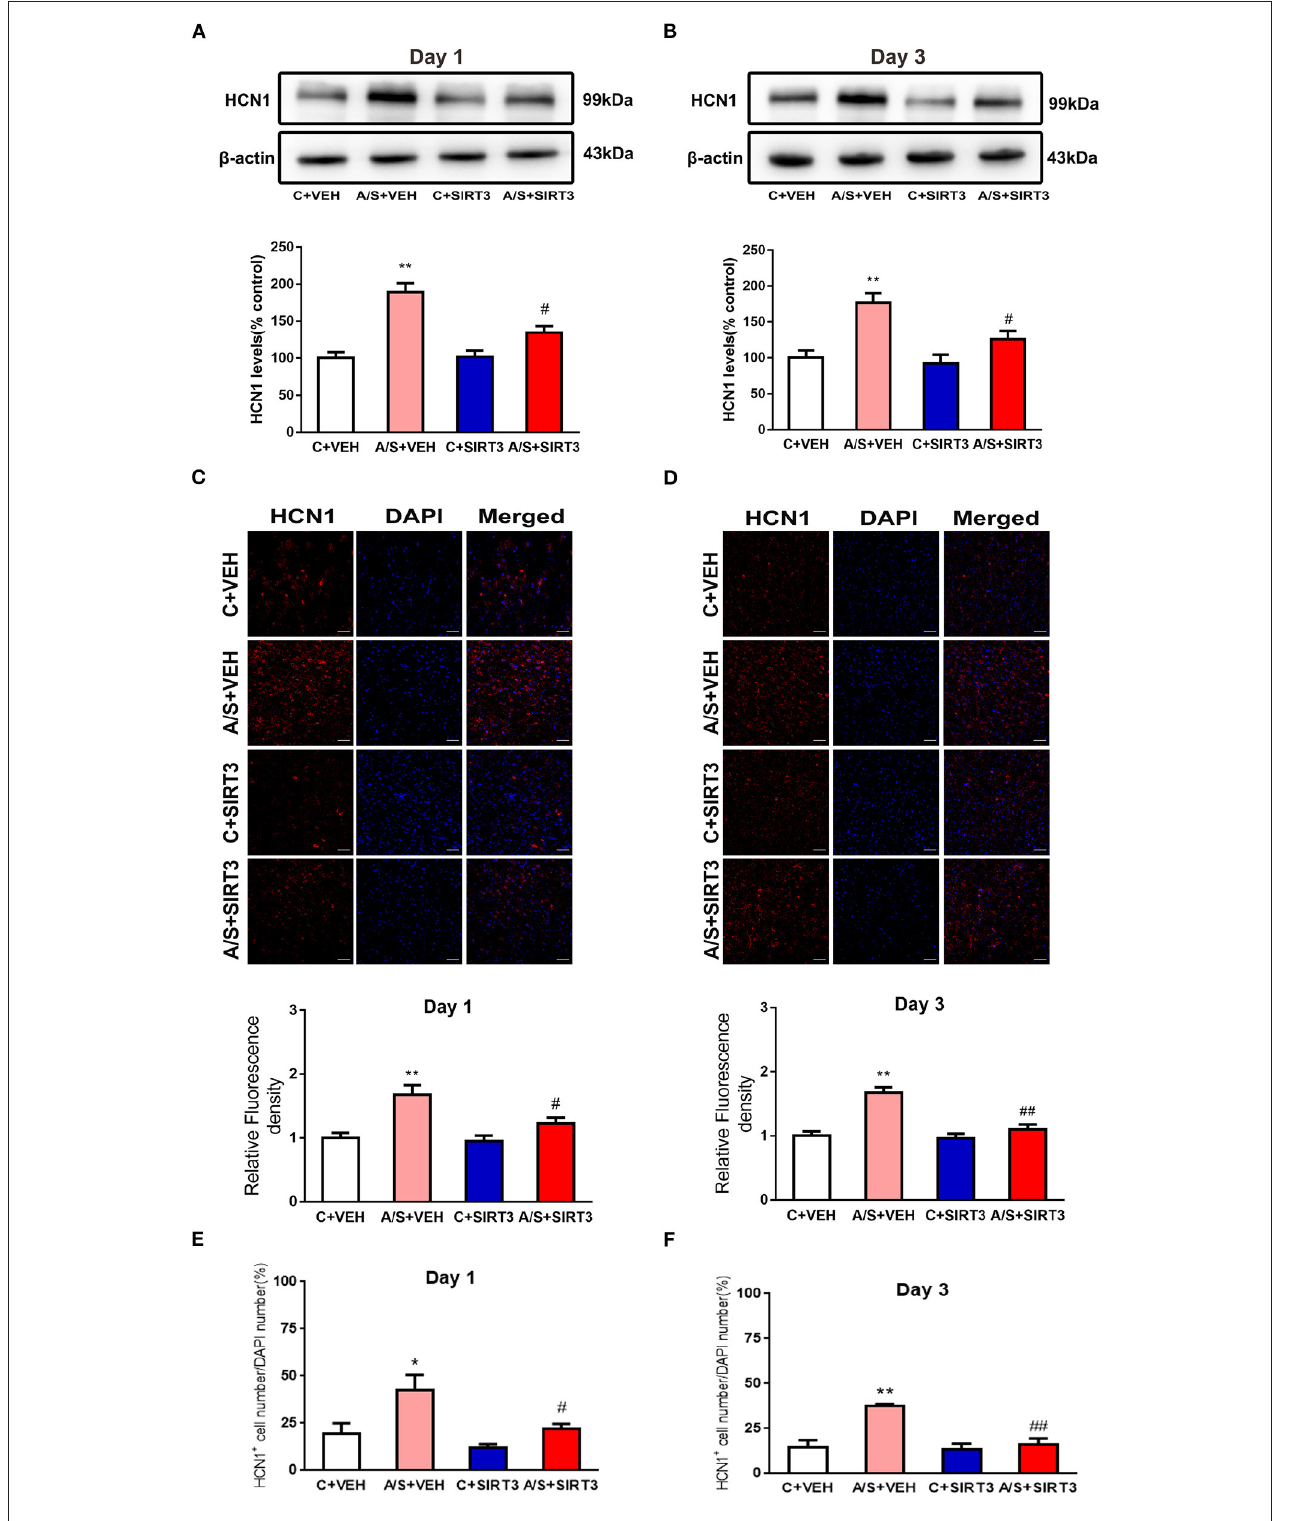
FIGURE 4 | Effect of SIRT3 overexpression on the HCN1 channel. (A,B) Representative western blots and quantification of HCN1 levels in mPFC area. (C–F) Representative images and quantification of HCN1 fluorescence in mPFC area ( n = 6 per group, * p < 0.05; ** p < 0.01; # p < 0.05; ## p < 0.01). Data are presented as the means ±